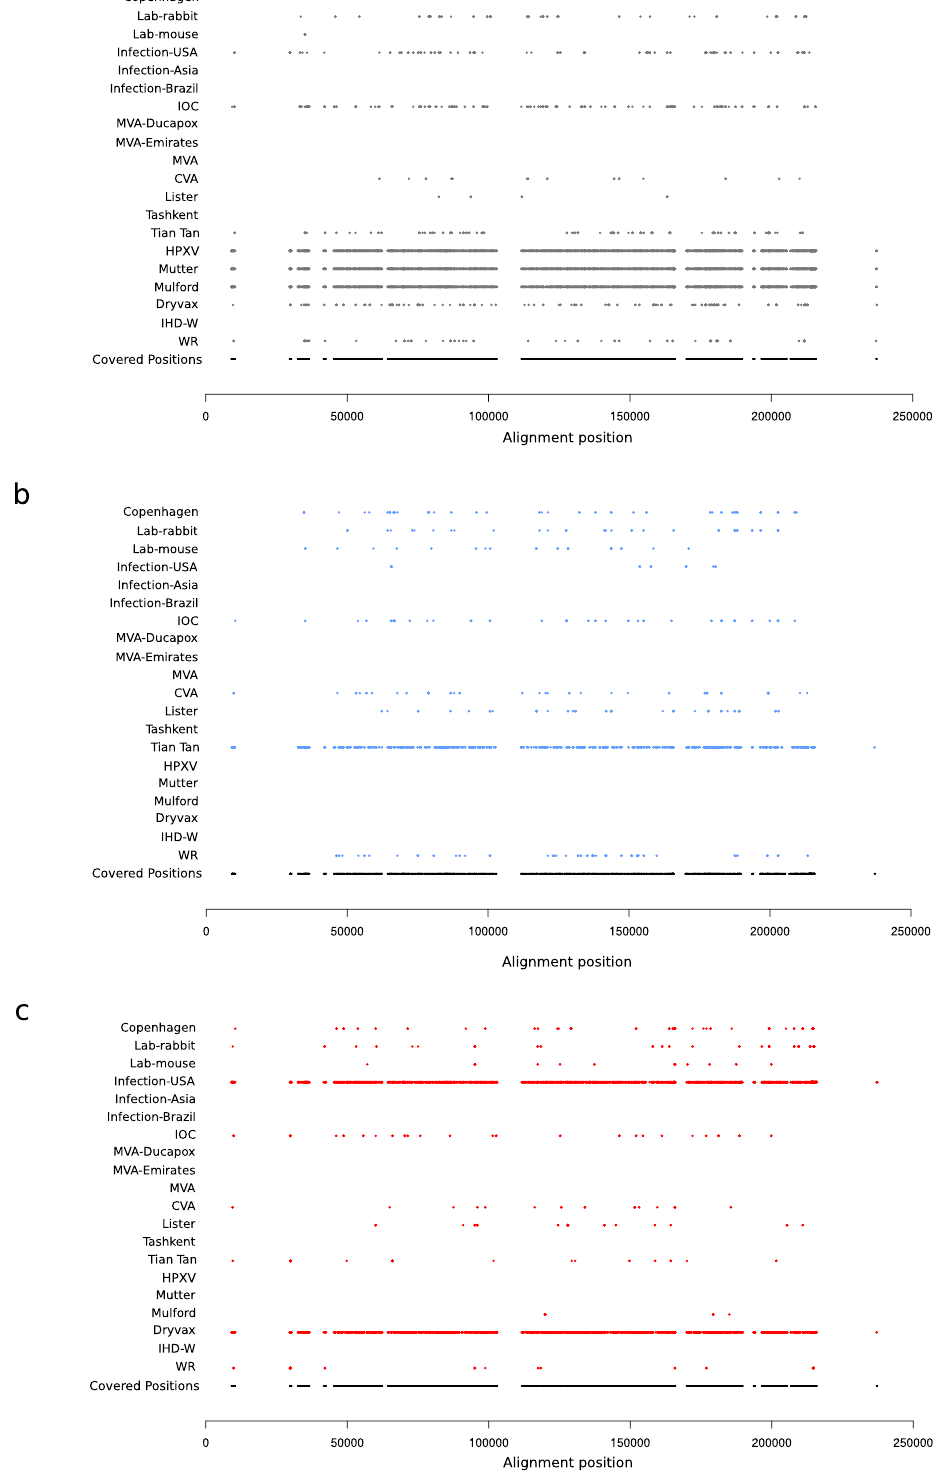
Fig. 4 Ancestral component probabilities at nucleotide resolution. Site by site probability of ancestry components for a subset of VACV genomes. Each line represents a randomly selected virus for each of the clones/populations of VACV; each dot represents a PI site with a probability >0.75 to derive from the a HPXV, b Tian Tan, and c Dryvax ancestry component. Colors are the same as in Fig. 3. The bottom line represents the position of all PI sites (as black dots) analyzed in this study. Positions refer to the genome alignment. Regions that are not covered by PIs are highly dynamic and sequence information was present for less than 90% of